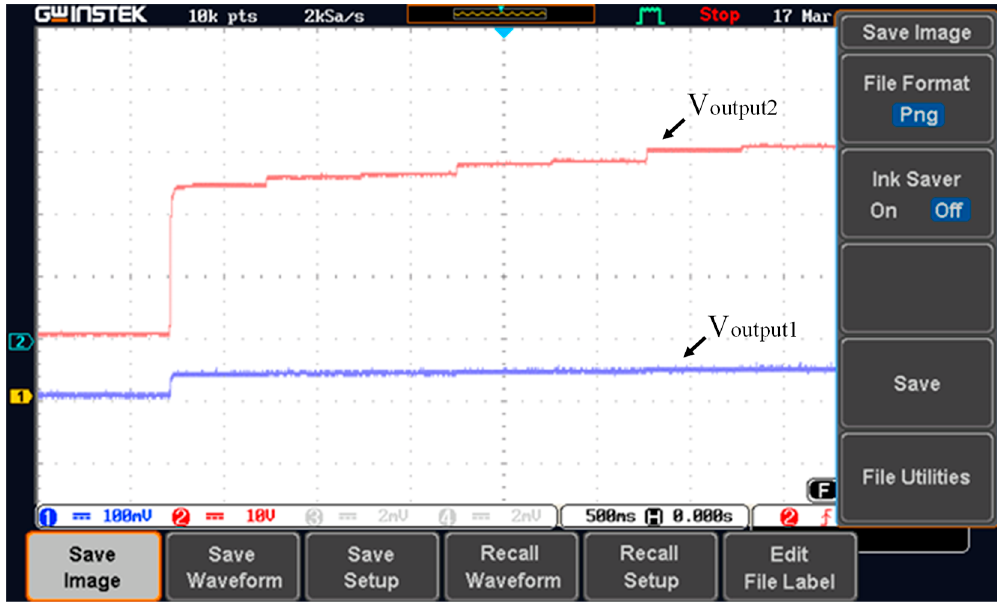
Figure 18. Variable voltages waveform when step change in load.